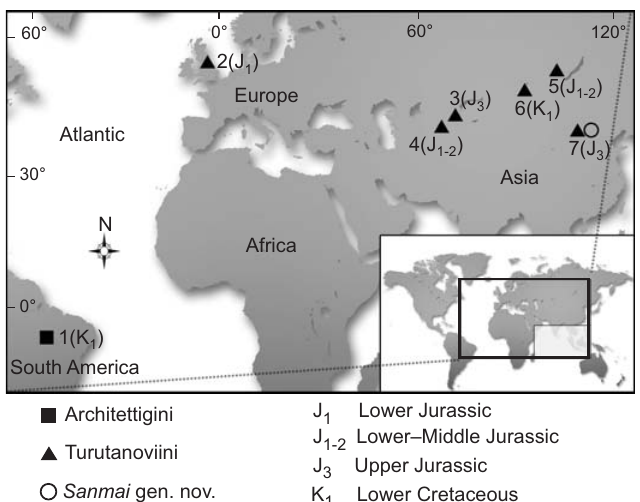
Fig. 1. Distribution of the localities and strata of Architettigini, Turutano viini, and Sanmai gen. nov. 1, northeastern Brazil (Hamilton 1990); 2, England (Whalley 1985); 3, Kazakhstan (Shcherbakov and Popov 2002; Shcherbakov 2009); 4, Tajikistan (Becker-Migdisova 1949); 5, Ust’-Baley, southern Siberia (Shcherbakov 1985); 6, Myangad, western Mongolia (Shcherbakov 1986); 7, northeastern China (Wang and Zhang 2009; this